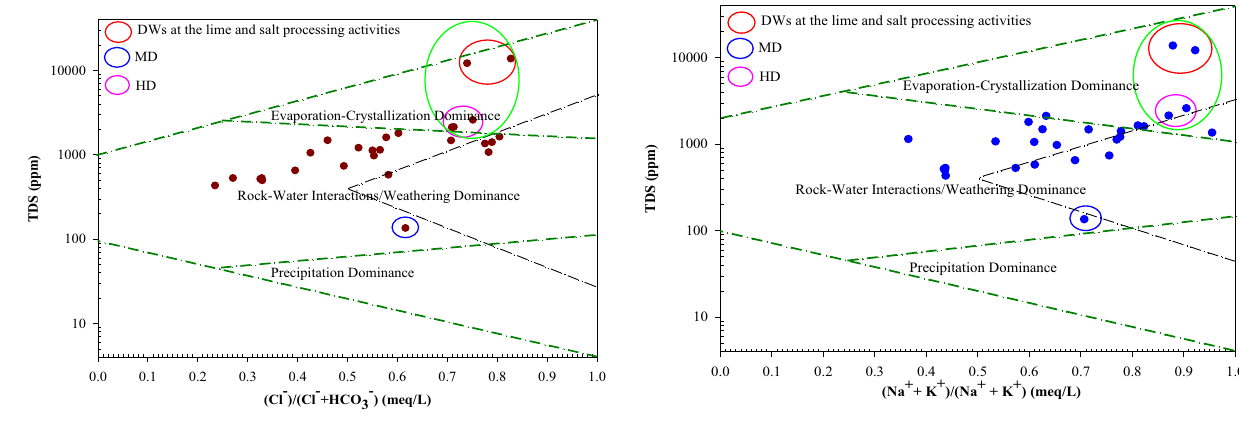
Fig. 4 The major mechanisms controlling the quality of water based on